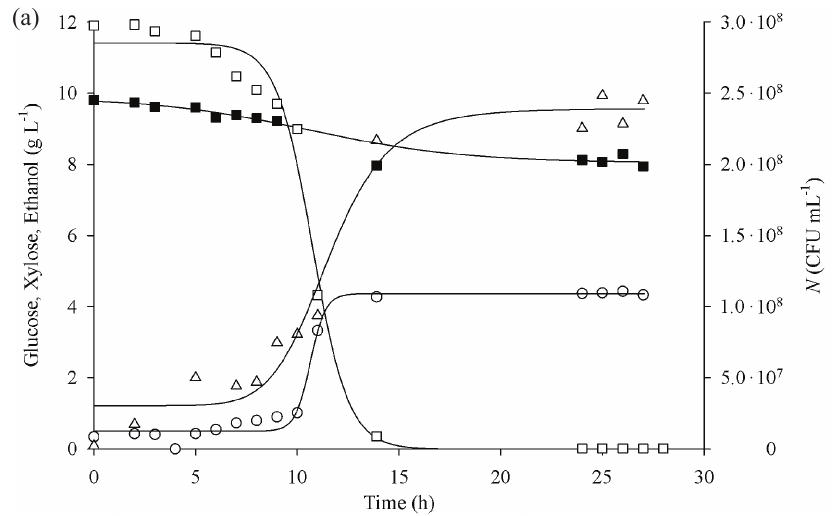
Fig. 7 – Changes in glucose (□), xylose (  ), ethanol (○), and cell number (N, ∆) con - centrations during anaerobic cultivation of genetically engineered S. cerevisiae on liquor wheat straw hydrolysate media obtained at 180 °C/5 min/0.5 % w/w H